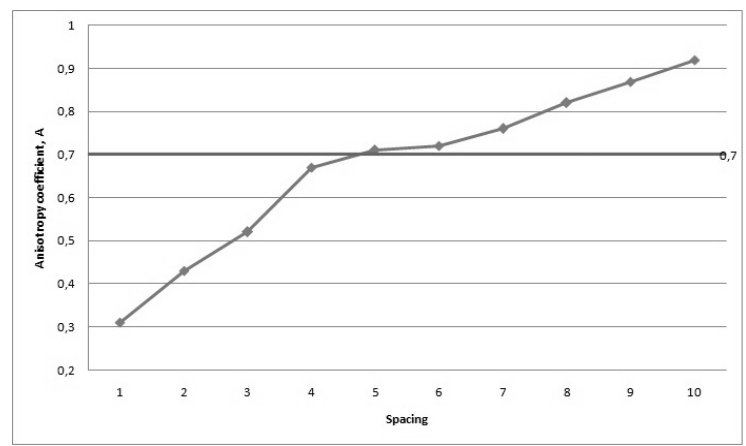
Figure 6. Distribution of the coefficient of anisotropy in the drawn wire from its surface to center.